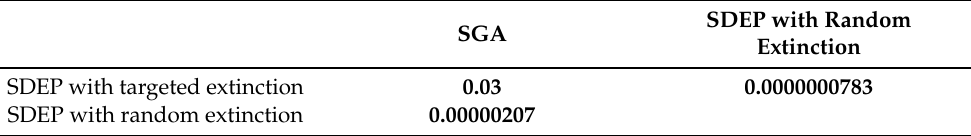
Table 9. Pairwise Wilcoxon signed-rank test of Rastrigin fitness performance among SGA, SDEP with random extinction, and SDEP with targeted extinction. The results in bold are statistically significant with a 95% confidence level. p -values are adjusted using Bonferroni